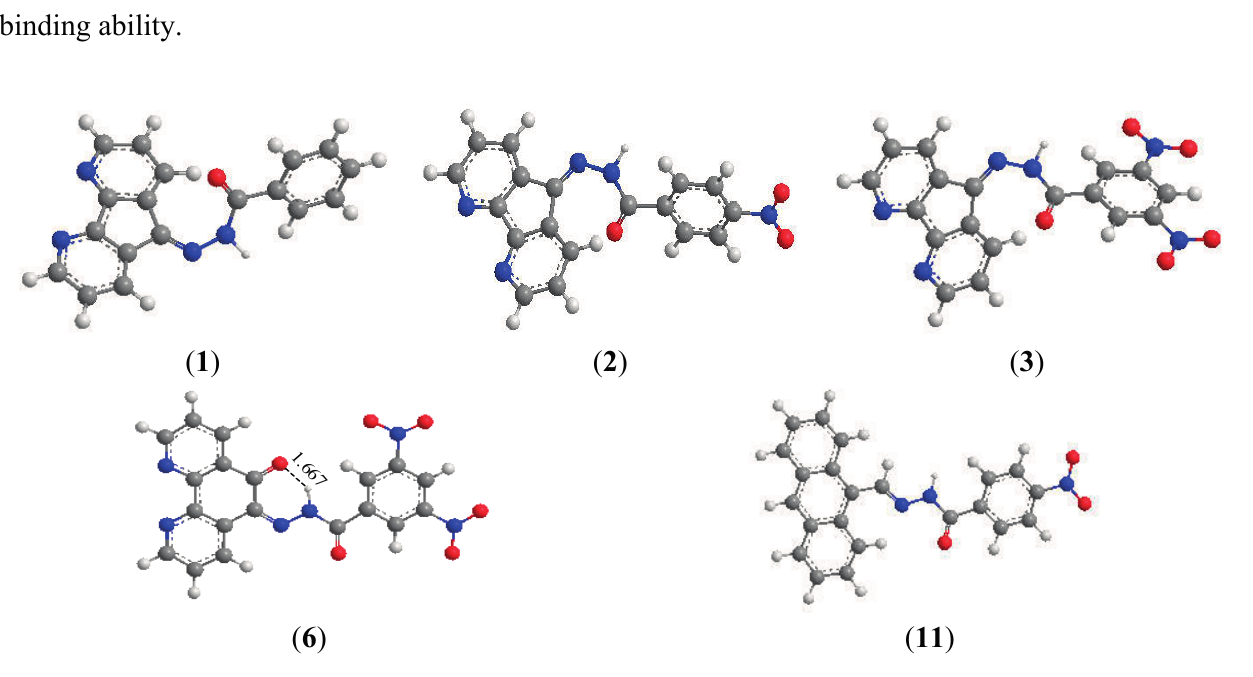
Figure 5. The optimized structures of synthesized compounds ( 1 , 2 , 3 , 6 and 11